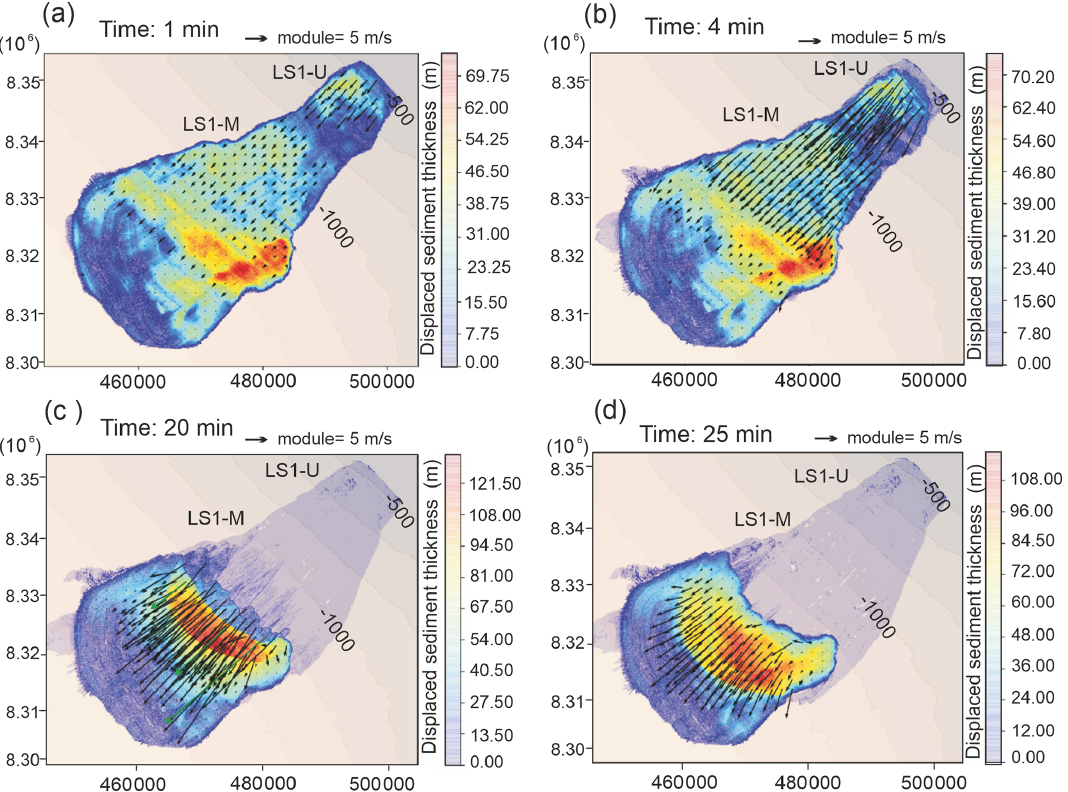
Figure 6. Velocity pattern of the landslide in different frames and the displaced sediment thickness. (a) A 1min frame, where the upper- slope domain (LS1-U, ∼ 500m water depth, 3 ◦ slope gradient) with an average velocity v u = 5ms − 1 contrasts with the mid-slope domain (LS1-M, ∼ 1000m water depth; 2 ◦ slope gradients) with an average velocity v m = 1ms − 1 . (b) A 4min frame, with a progressive velocity increase in both areas ( v u = 30ms − 1 and v m = 22ms − 1 , respectively). (c) A 20min frame, where velocity is maximum in the frontal area as v f = 20ms − 1 , coinciding with maximum sediment thickness displacement (122–108m) and decrease towards the sides as v s = 15ms − 1 . (d) A 25min frame, where both moving masses are joined with central velocity v f = 10ms − 1 and lateral velocity v s = 2–5ms − 1 in the distal area ( ∼ 1500m water